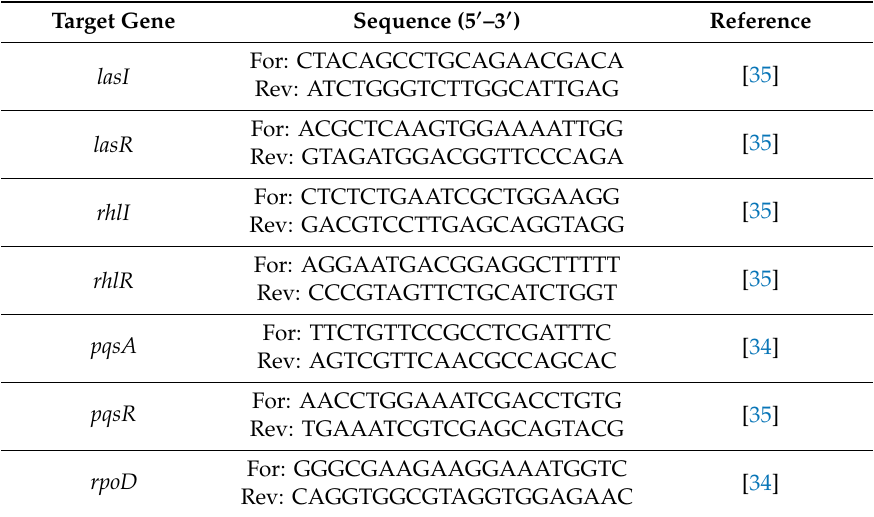
Table 1. Sequences of the used primers in this